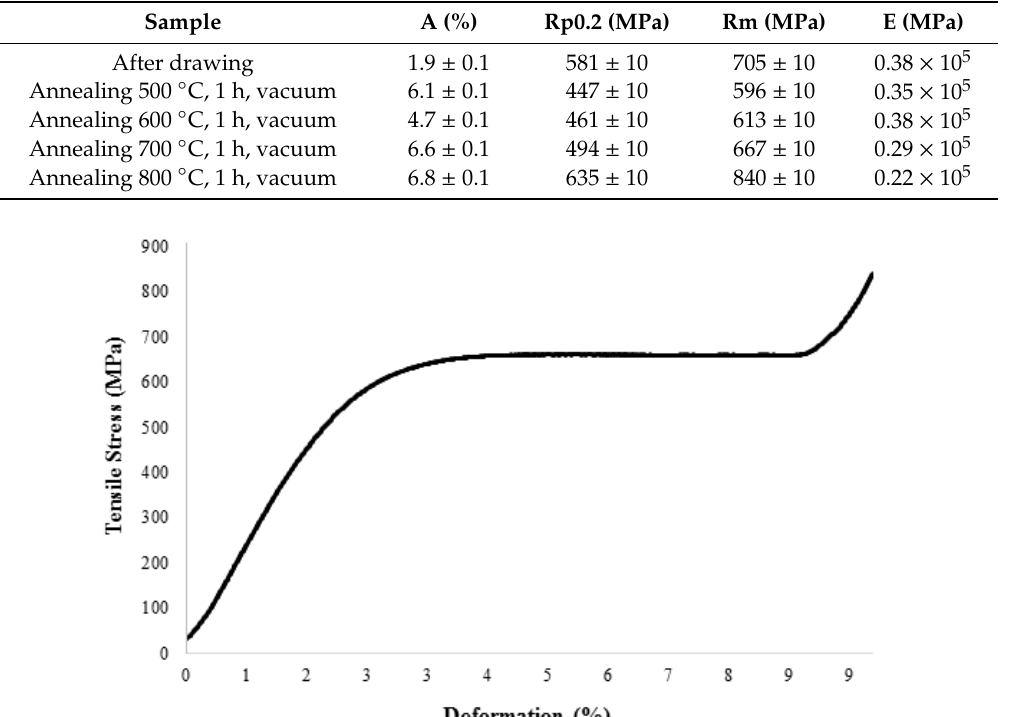
Figure 12. X-ray di ff raction (XRD) patterns of Ti–28Nb–5Zr wire after drawing. Figure 12. X-ray diffraction (XRD) patterns of Ti–28Nb–5Zr wire after drawing. Table 1. Data on mechanical testing of wire depending on heat treatment.